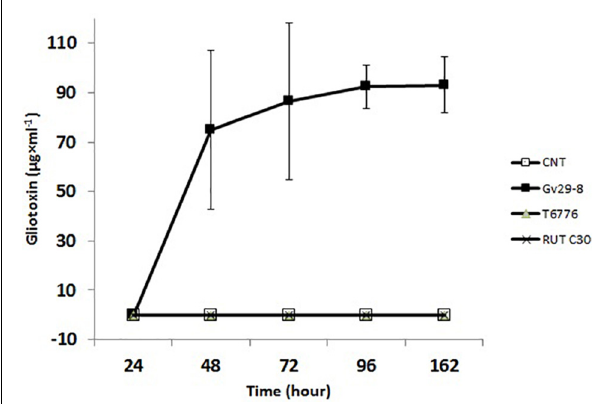
FIGURE 3 | Gliotoxin time course production in TvGv29, TaT6776, and TrRUTC30, grown in Weindling medium up to 162 h, detected by high-performance liquid chromatography (HPLC). Data points represent the average ± standard deviation of biological replicate cultures ( n = 3).